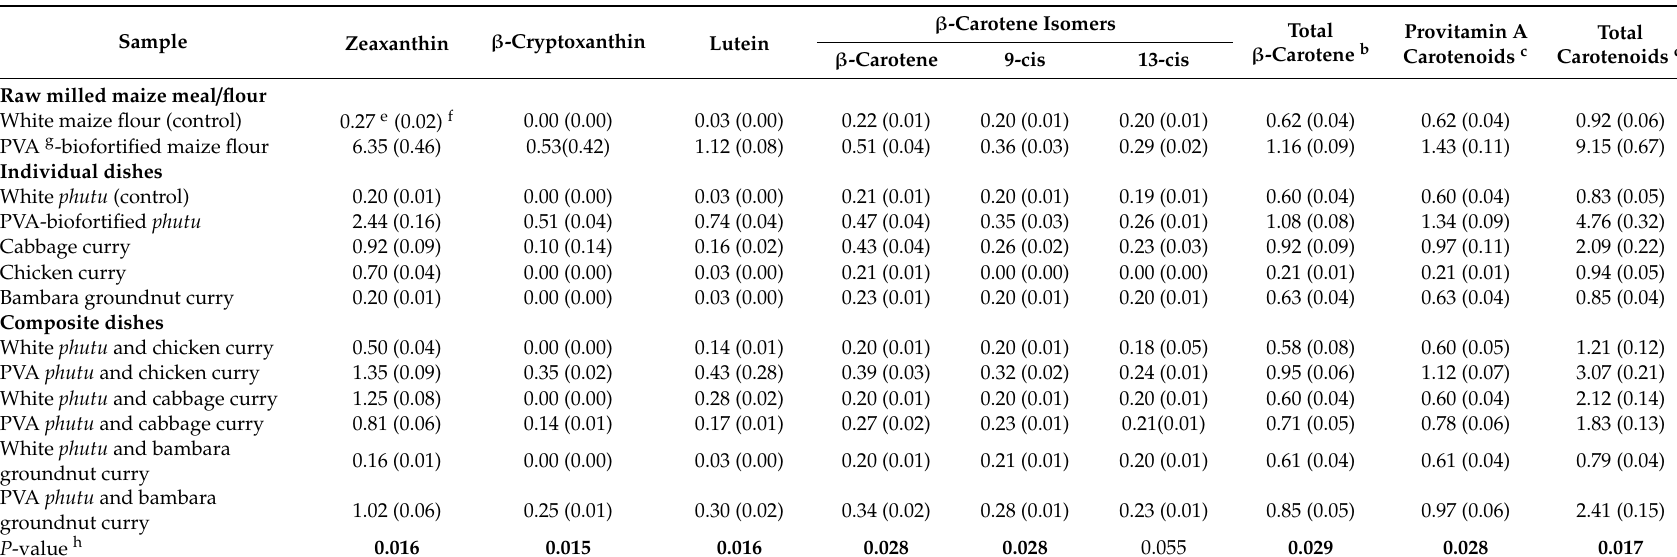
Table 9. Provitamin A content of provitamin A-biofortified maize composite dishes ( µ g / g, DW a ).